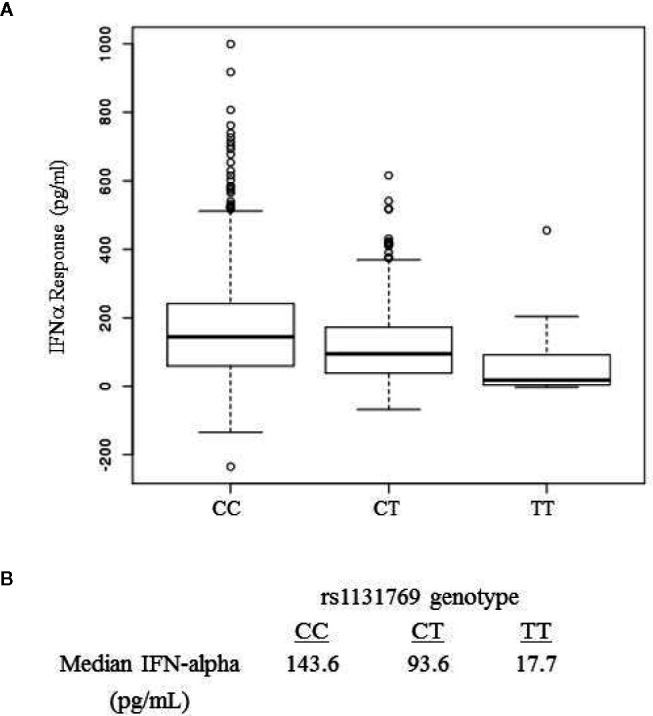
IFNa response in smallpox vaccine recipients displays a dose-dependent association with rs1131769. (A) Box and whisker plots for major allele homozygotes (CC), heterozygotes (CT), and homozygous minor allele (TT) subjects. The C allele corresponds to the R232 STING variant and the T allele corresponds to the H232 STING variant. (B) Median IFNa response (pg/mL) by rs1131769 genotype group.